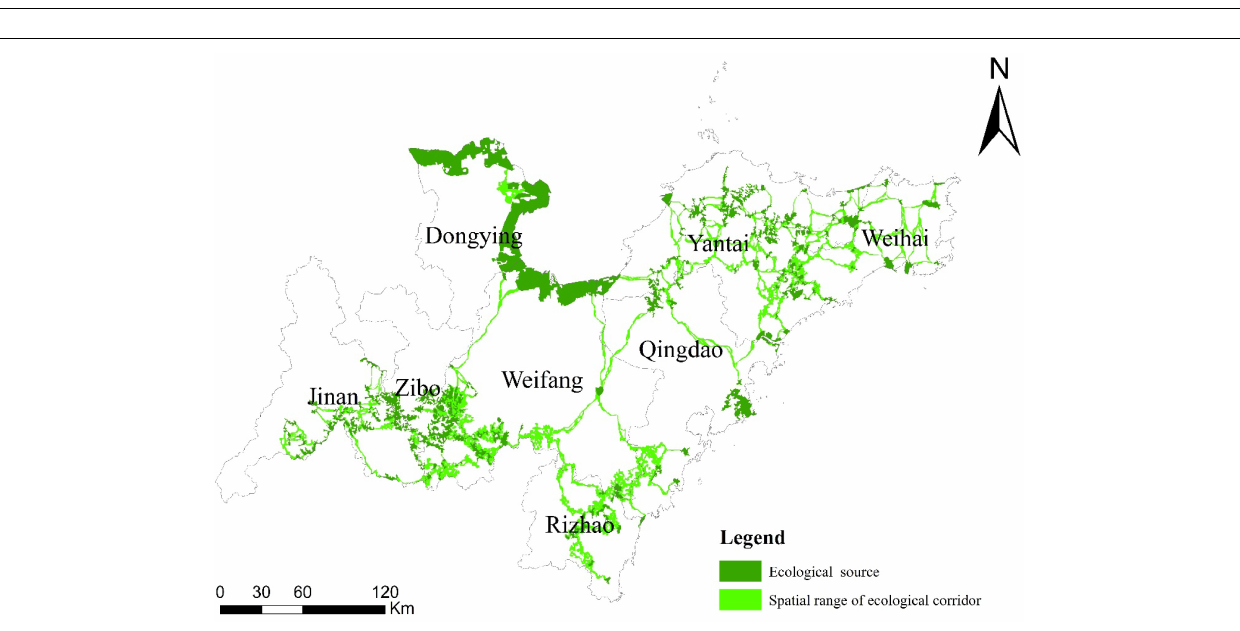
FIGURE 9 | Spatial distribution of ecological networks (ENs) in Shandong Peninsula urban agglomeration.